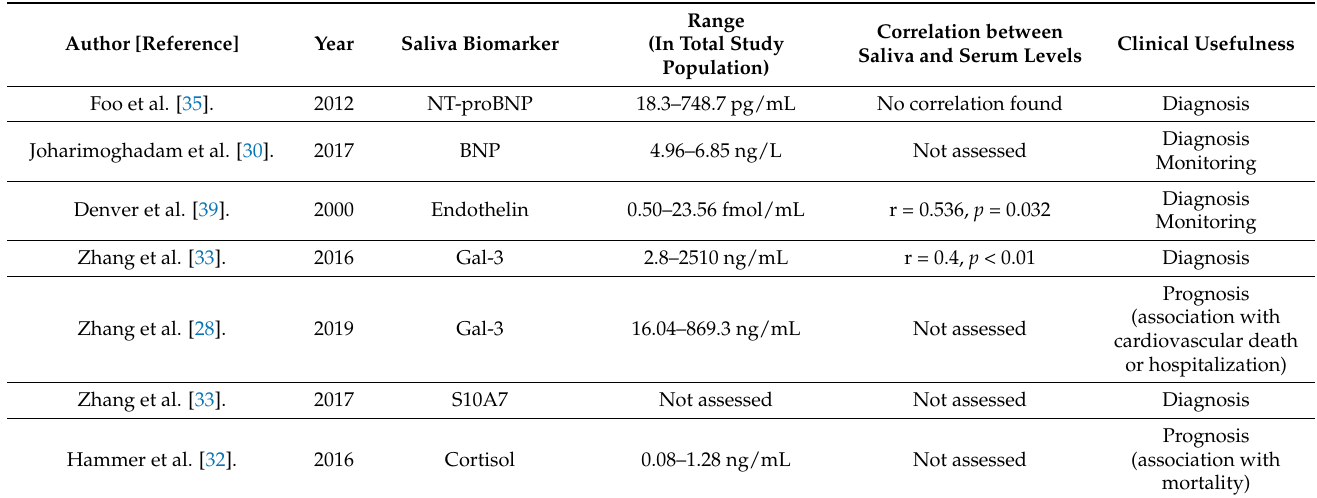
Table 2. Saliva biomarkers that have shown a potential role in HF